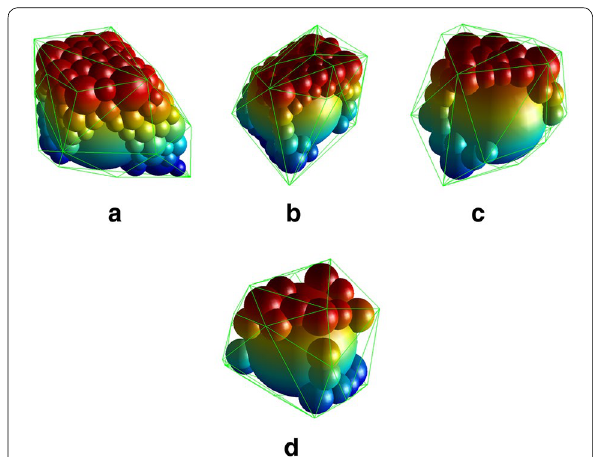
Fig. 2 Four kinds of typical clusters before scaling. a A, b B, c C, d